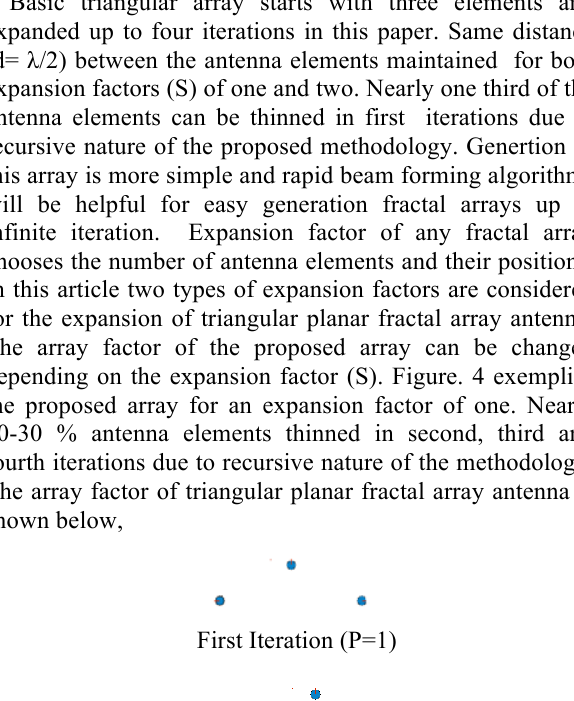
this array configuration.